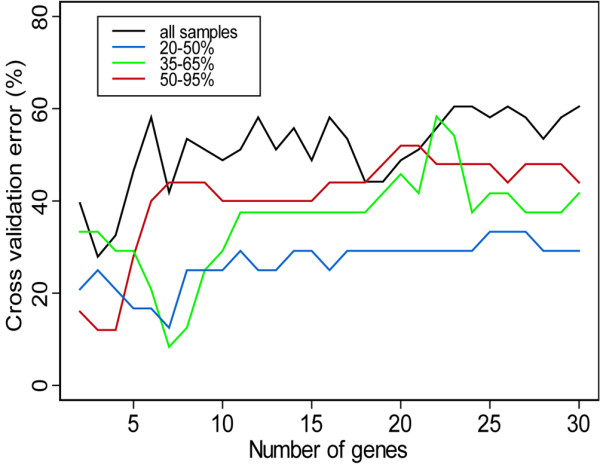
Leave-one-out cross-validation (LOOCV) error rates for response prediction. Variation in the LOOCV error estimate with the number of genes used in the predictor. Misclassification rates are plotted for the whole data set (n = 43) and subsets according to percentage tumour content.